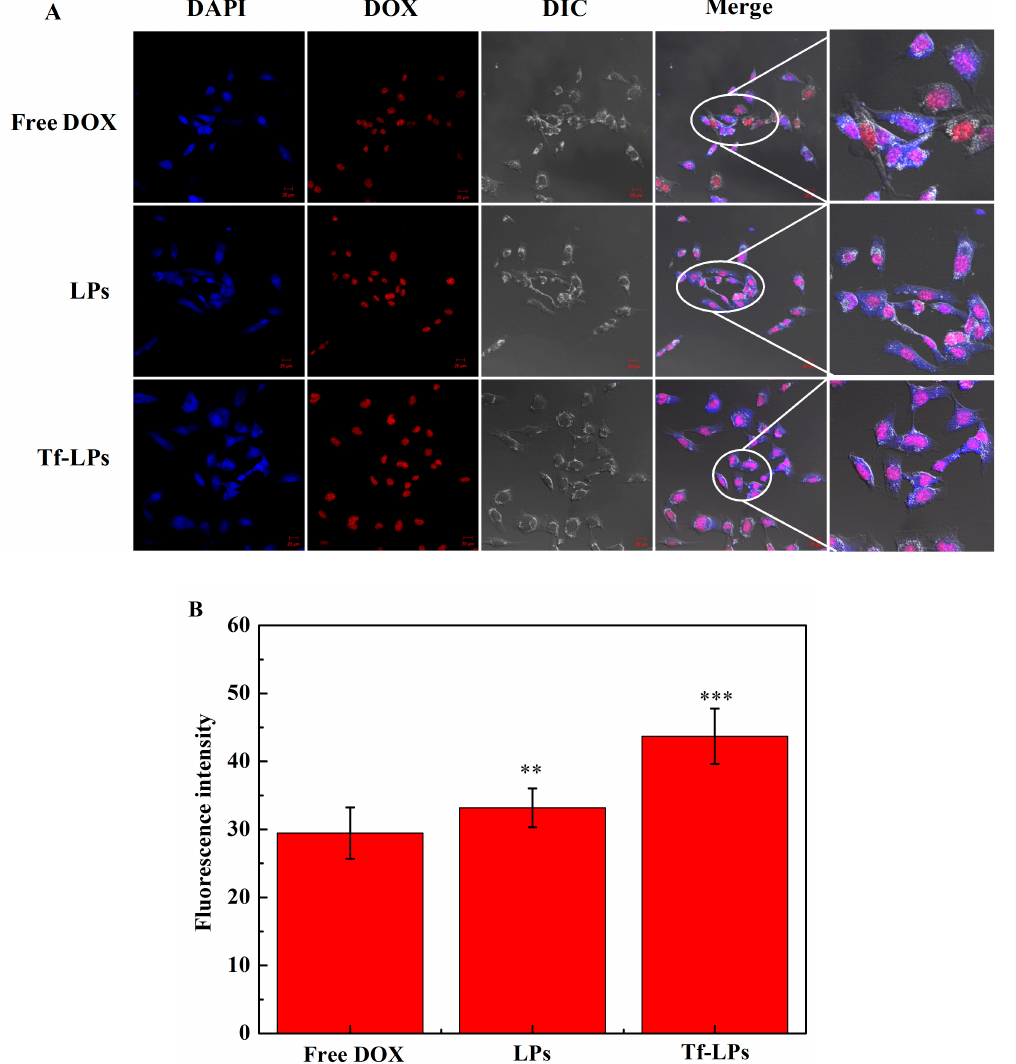
Figure 4. Cellular uptake of Tf-LPs ( n = 3). ( A ) CLSM images of GL261 cells after incubation with free DOX, LPs and Tf-LPs for 4 h, ( B ) the fluorescence intensity of DOX channels when GL261 cells were treated with free DOX, LPs and Tf-LPs for 4 h. GL261 cells showed the best cellular uptake for Tf-LPs. Abbreviations: LPs, DOX-loaded liposomes; Tf-LPs, DOX-loaded Tf-liposomes. ** p < 0.01, *** p < 0.001